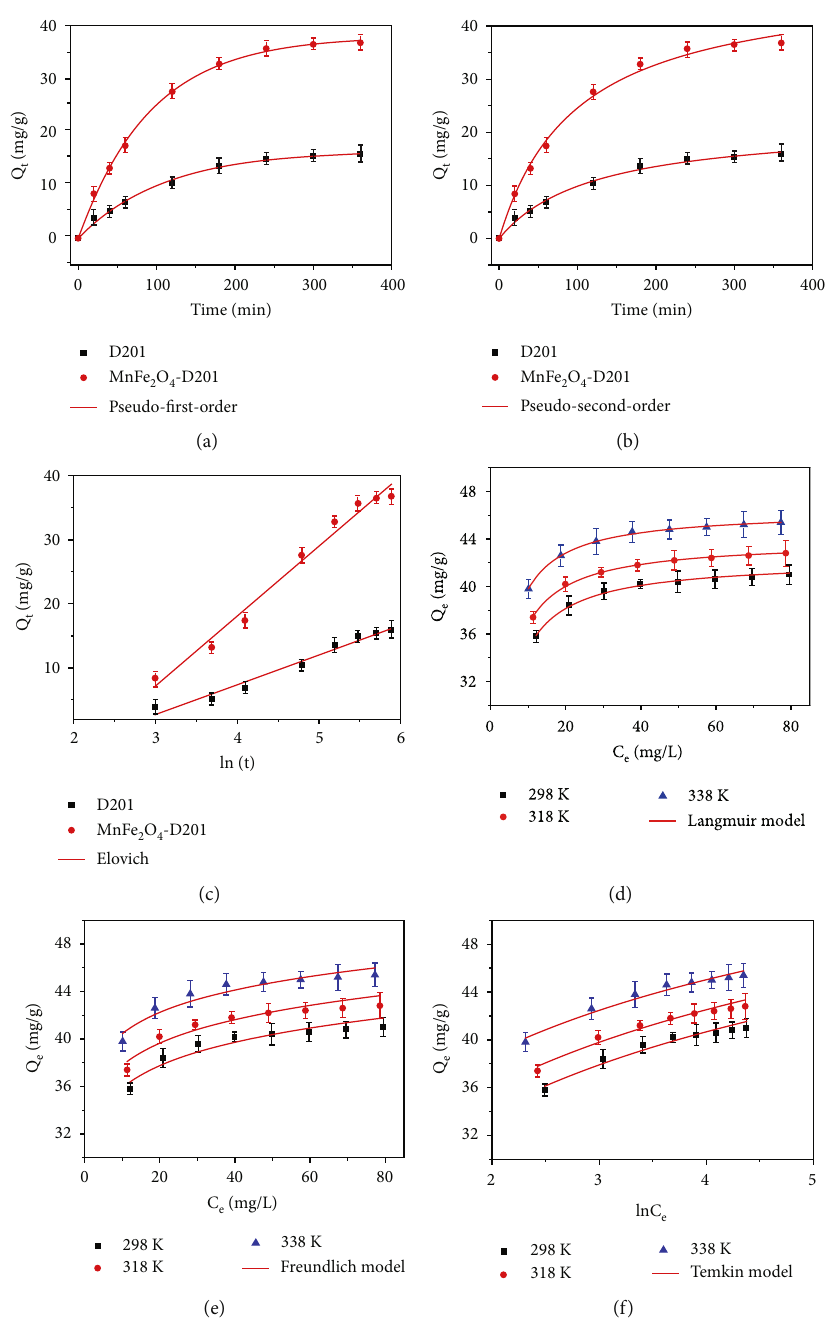
O /D201, 150rpm; adsorption kinetics: adsorption times are 2 4